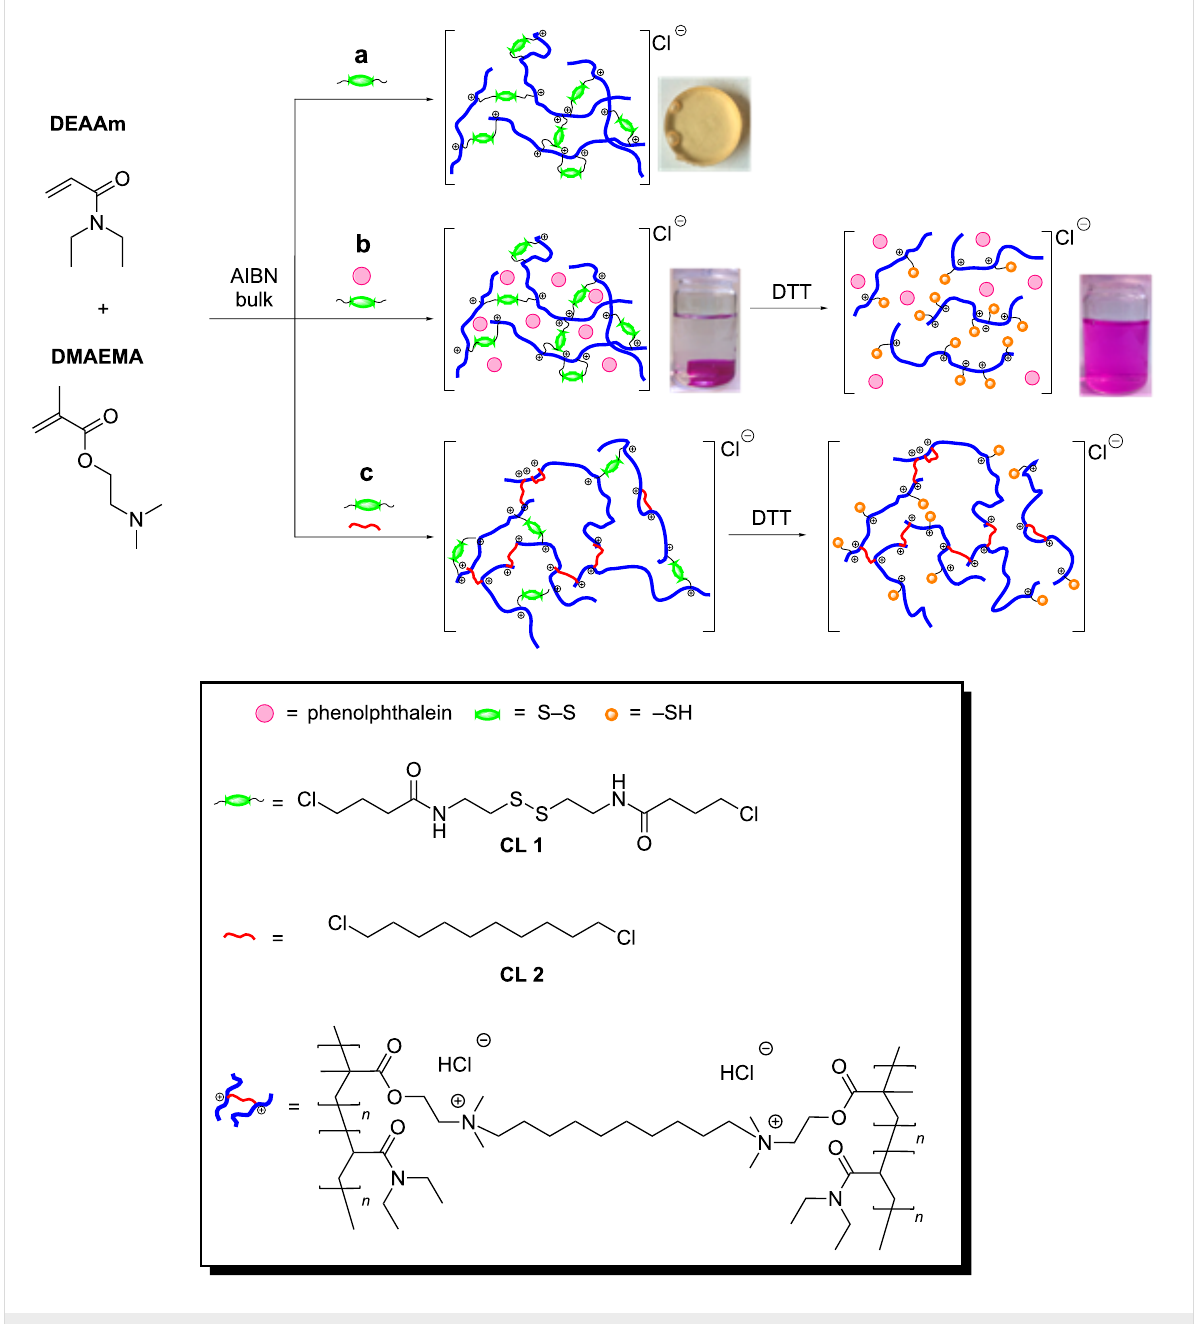
Scheme 2: Synthesis of poly(DEAAm- co -DMAEMA) discs. (a) Cross-linked discs with CL 1 . (b) Cross-linked discs with CL 1 and phenolphthalein. (c) Cross-linked discs with CL 1 and CL 2